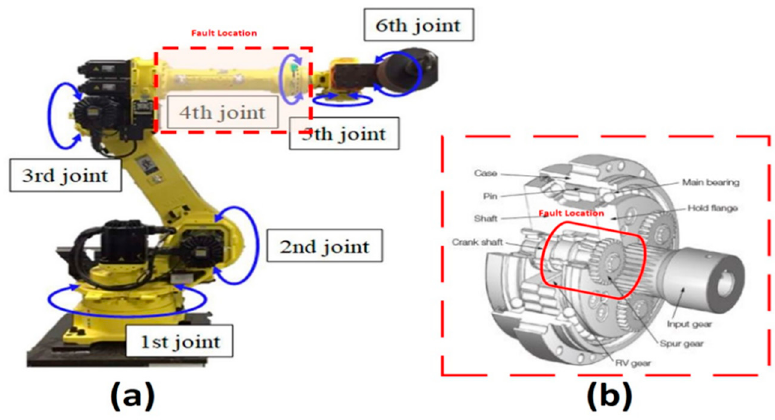
Figure 6. ( a ) Location of the fault, and ( b ) comprehensive logical view.